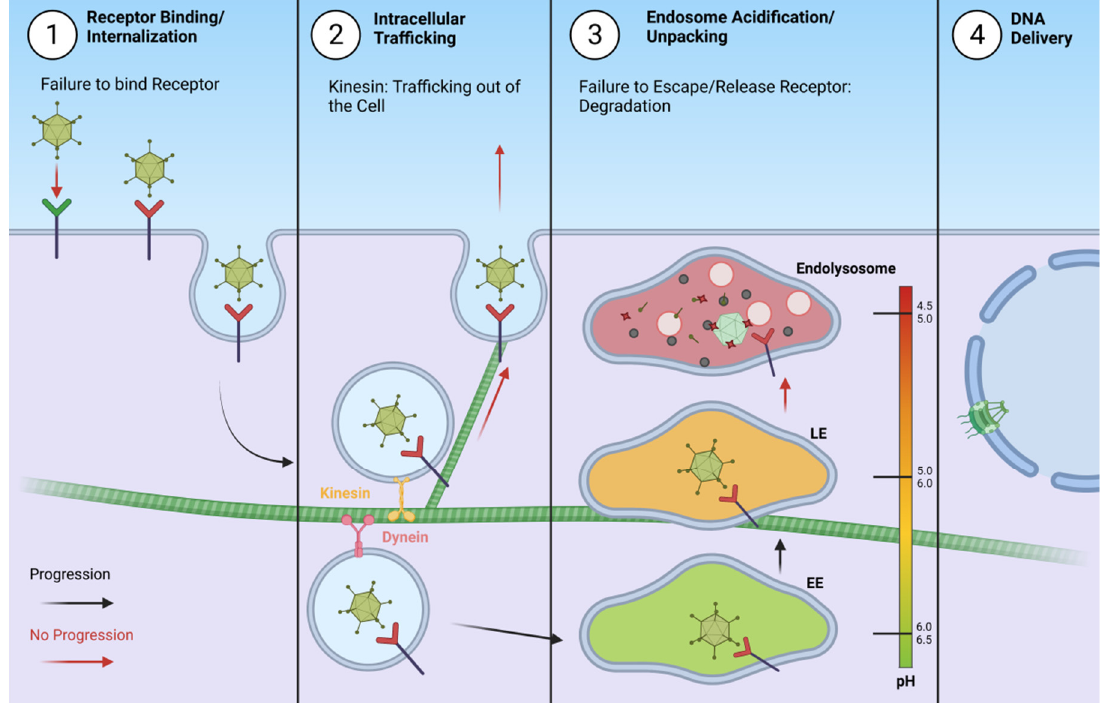
Figure 2. Unsuccessful delivery of the adenovirus genome may occur at several steps during the process of infection. 1. Binding an inadequate receptor that does not allow for internalization. 2. Vesicle trafficking via kinesin may lead to exocytosis of the virion. 3. Inability to escape the endosome due to firm binding of the receptor may cause accumulation and eventually lead to degradation in the endolysosome. 4. Unsuccessful infection prevents genome delivery and production of progeny virions.